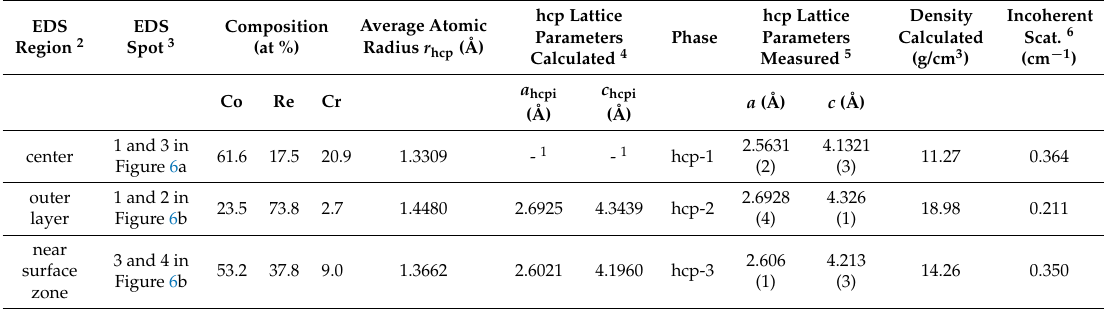
Table 1. Compositions of phases measured by EDS and other measured and calculated parameters for 1000 ppm B sample.